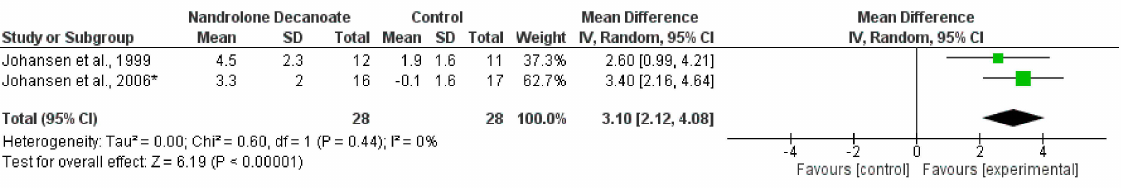
Figure 8. Effect of nandrolone decanoate on lean whole body mass (mean change data) measured by DEXA in haemodialysis patients. Data are expressed as mean difference and 95% CI. * Data for nandrolone decanoate and control groups only [15,20].